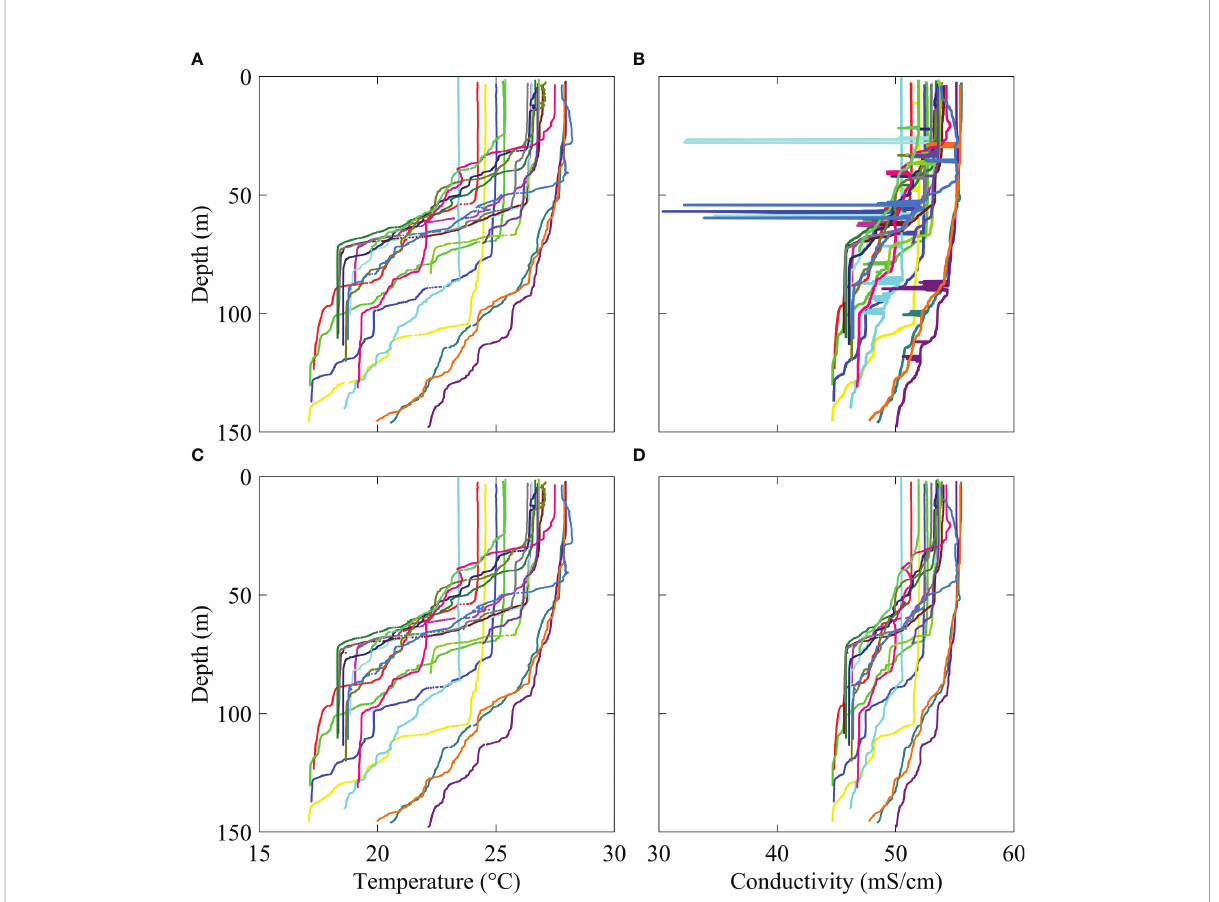
FIGURE 1 The 20 CTD conductivity and temperature pro fi les treated in this work. A , C and B , D represent two sets of temperature and conductivity data,